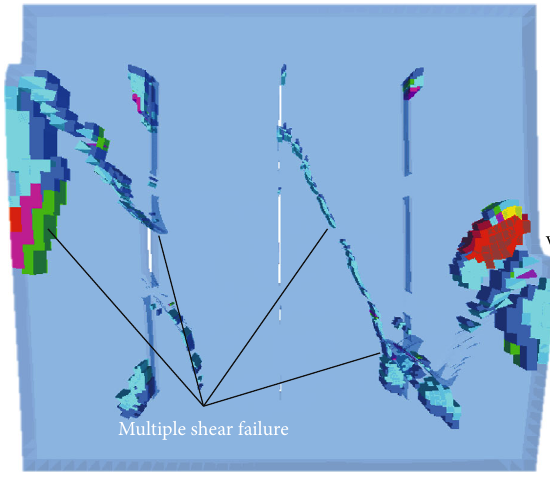
Figure 10: Failure of the model when β = 90 °